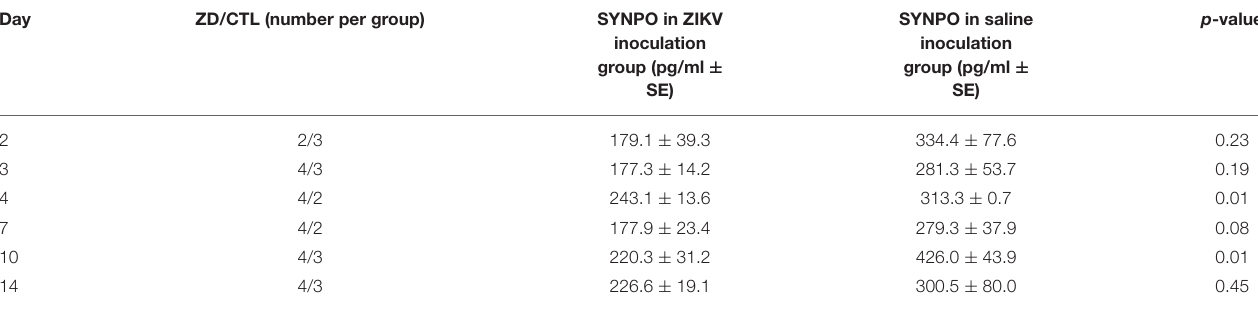
TABLE 2 | Mean fetal neural ECV synaptopodin by day following ZIKV inoculation (ZD) vs. saline injection (CTL).